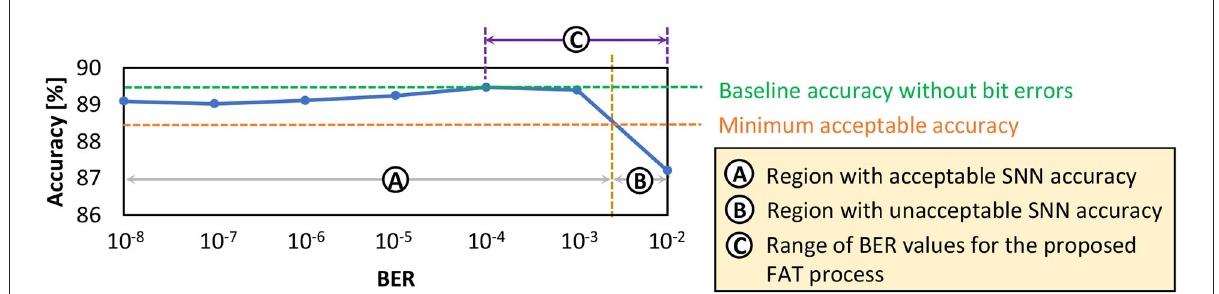
FIGURE9 The test accuracy profile of a 900-neuron network shows the region with acceptable accuracy, the region with unacceptable accuracy, and the range of BER values for the proposed fault-aware training. Note that this network is the same as the one in Figure 8. Here, the observation focuses on the BER values that can be considered in the retraining process, thereby having a smaller range than the one in Figure 8.